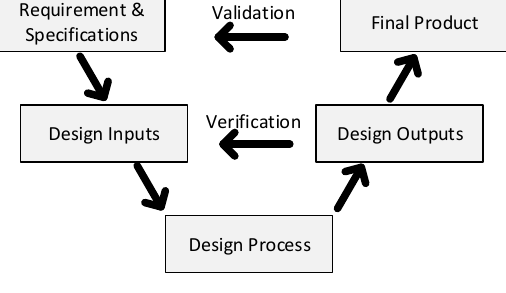
Figure 1. Design procedure [1–3].